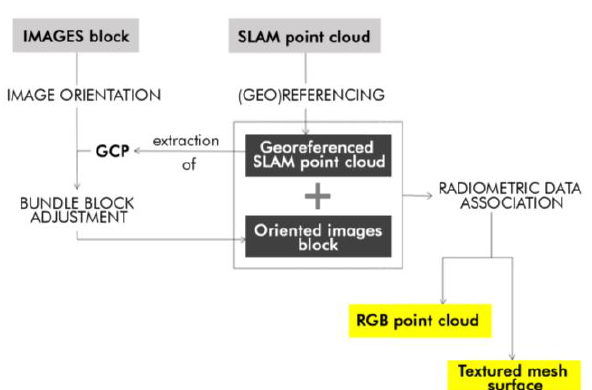
Table 7. Comparison of RMS errors from the two blocks adjustment configurations